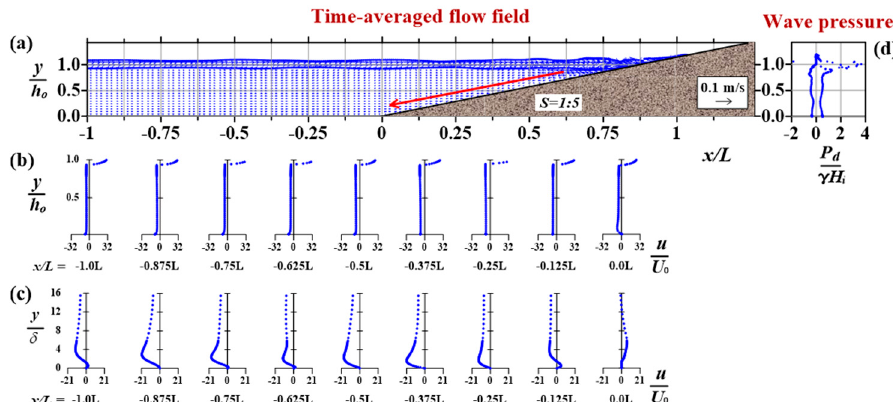
Figure 12. Time − averaged simulation results of the periodic incident wave ( 𝑈𝑟 = 4.7) propagation on a steep seawall with a slope of 1:5. ( a ) The time − averaged flow field; ( b ) the averaged horizontal velocity profile; ( c ) the averaged horizontal velocity profile in the boundary layer; ( d ) the maximum wave pressure on the seawalls.